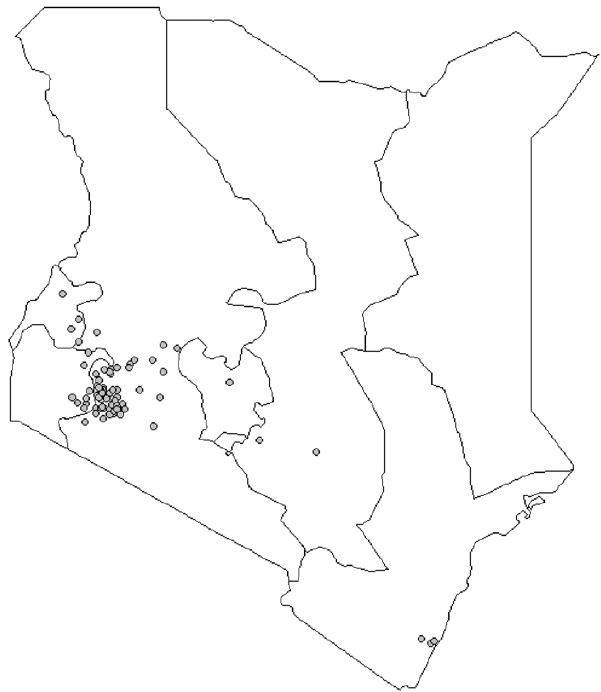
Figure 1. Home villages of young esophageal cancer patients. Locations of the home villages of the 109 esophageal cancer patients # 30 years of age seen at Tenwek Hospital (star) from January 1996 through June 2009. doi:10.1371/journal.pone.0014080.g001 Table 2. Distributions of 60 esophageal cancer patients #